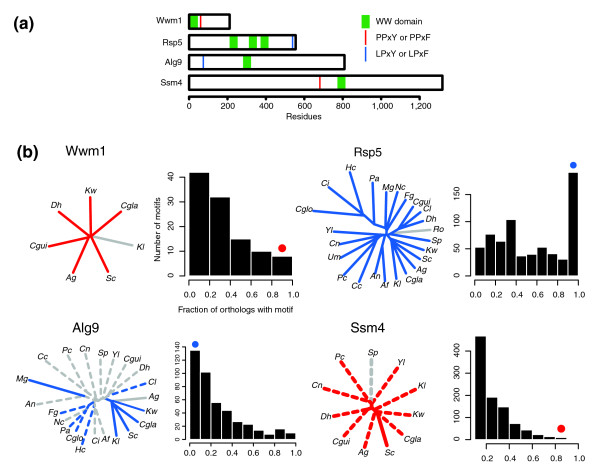
Co-occurrence of WW domains and WW domain binding sites. (a) Positions of the WW domains (green bars) and conserved primary sequence motifs (PPxY/F in red, LPxY/F in blue) in Wwm1, Rsp5, Alg9 and Ssm4. (b) Radial trees and motif conservation for the ortholog groups of each protein. Organism abbreviations are Saccharomyces cerevisiae (Sc),Candida guilliermondii (Cgui),Candida glabrata (Cgla),Chaetomium globosum (Cglo),Kluyveromyces waltii (Kw),Kluyveromyces lactis (Kl),Yarrowia lipolytica (Yl),Candida lusitaniae (Cl),Debaryomyces hansenii (Dh),Schizosaccharomyces pombe (Sp),Pneumocystis carinii (Pc),Fusarium graminearum (Fg),Magnaporthe grisea (Mg),Neurospora crassa (Nc),Podospora anserina (Pa),Aspergillus fumigatus (Af),Aspergillus nidulans (An),Ashbya gosypii (Ag),Histoplasma capsulatum (Hc),Coccidioides immitis (Ci), Ustilago maydis (Um),Cryptococcus neoformans (Cn),Coprinus cinereus (Cc),and Rhizopus oryzae (Ro). Solid branches indicate lineages in which the WW domain is present; dashed lines indicate the absence of a WW domain. Colored branches indicate lineage in which a motif is present; lineages in gray lack the motif. The histograms represent the relative conservation of S. cerevisiae motifs of the form X-X-x-X among the orthologs. Red and blue dots indicate the bins that contain the highlighted motifs.